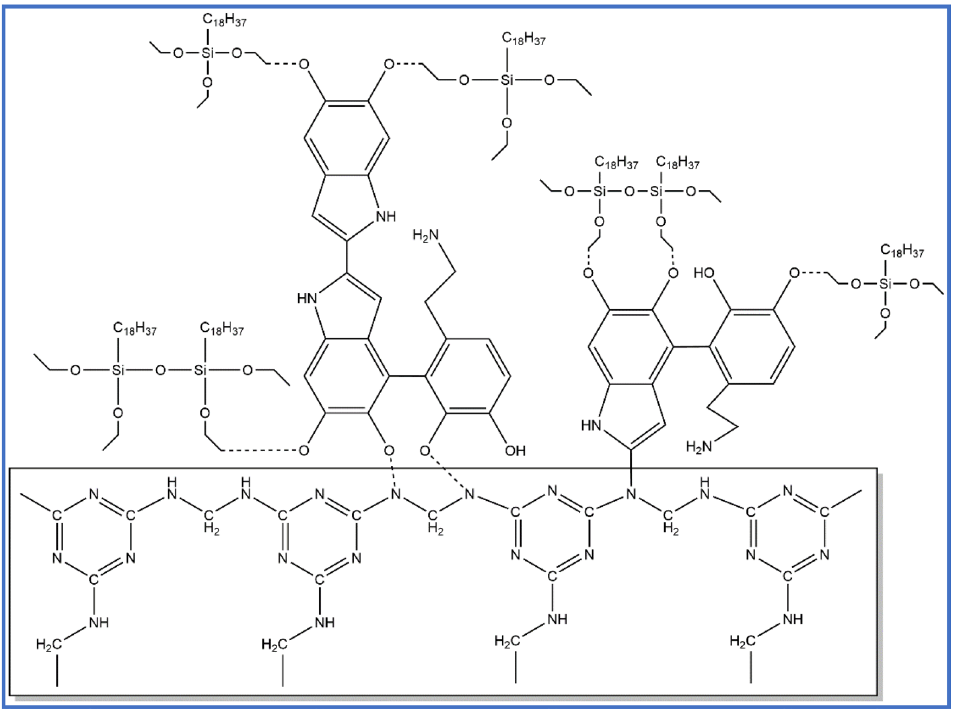
Figure 4. Interaction mechanism between PDA and OTS on the surface of